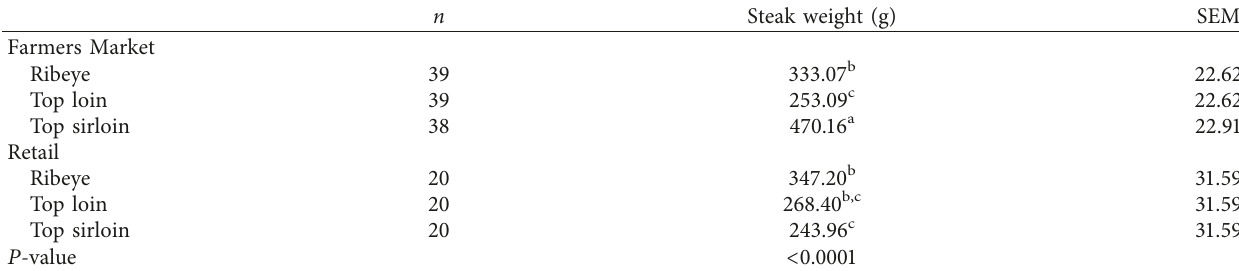
Table 4: Least squares means for steak weights (g) stratified by source × steak type. n